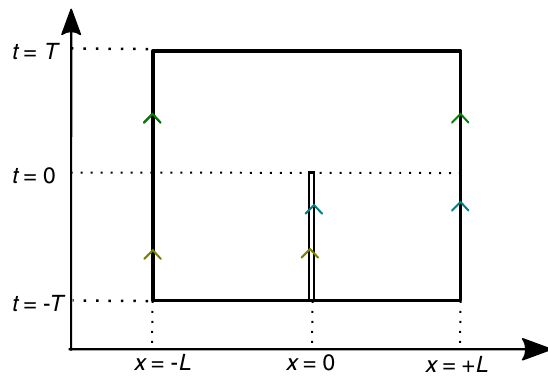
FIG. 6. The pair of pants as a crystalline gauge background. The branch-cut gluings are indicated with colored arrows. Here, ð x; t Þ ¼ ð 0 ; 0 Þ is a singularity of the smooth structure but not the continuous structure. It can be smoothed out into a high-curvature region but does not affect our calculations.